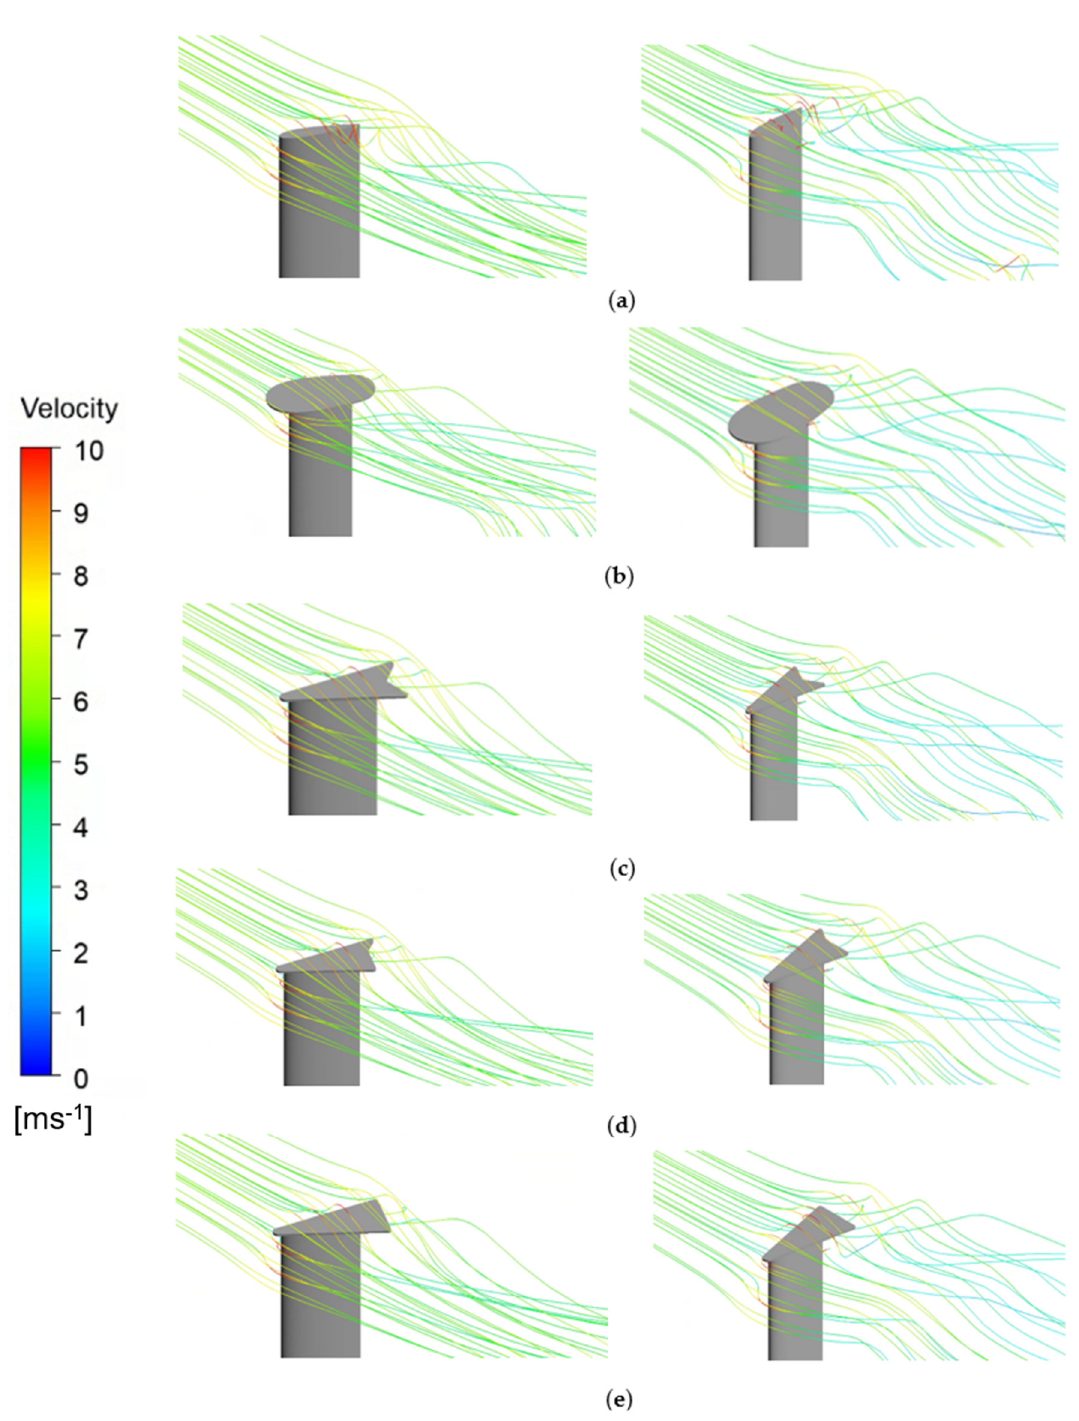
Figure 16. Velocity streamlines across the ( a ) baseline, ( b ) offset, ( c ) symmetric V, ( d ) asymmetric and ( e ) triangular endplates of Blade 1 at θ = 60° in TSR 1 (left column) and θ = 90° in TSR 2 (right column).